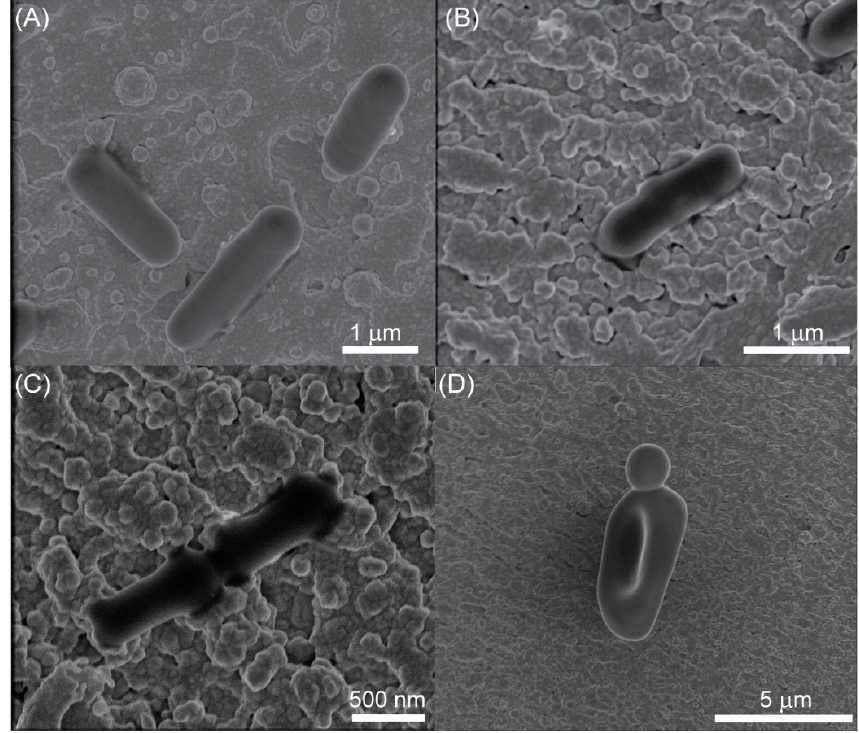
Figure 1. The SEM images of ( A ) Lactobacillus fermentum , ( B ) Bifidobacteium longum , ( C ) Prevotella bivia , and ( D ) Candida albicans dHp17 on the surface of the Si/Ag SERS